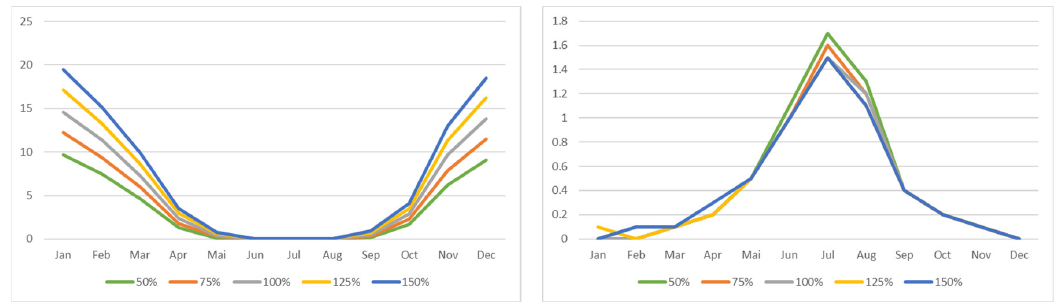
Figure 11 . Sensitivity of U-values on monthly energy needs for heating ( left ) and cooling ( right ). A volume to floor area coefficient of 0.32 (equivalent to 2.6 m of room height and assuming a factor 1.2 between the original area and floor area) was considered as reference value. For sensitivity analysis, room heights were varied from 2.2 to 3 m to understand their impact on modelling results.